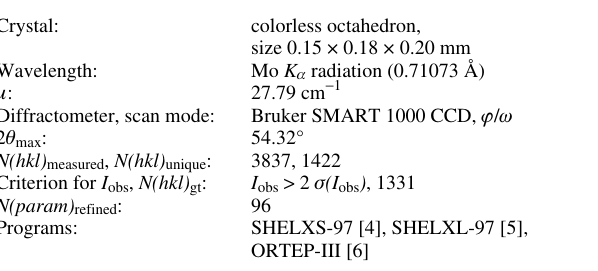
Table 1. Data collection and handling.